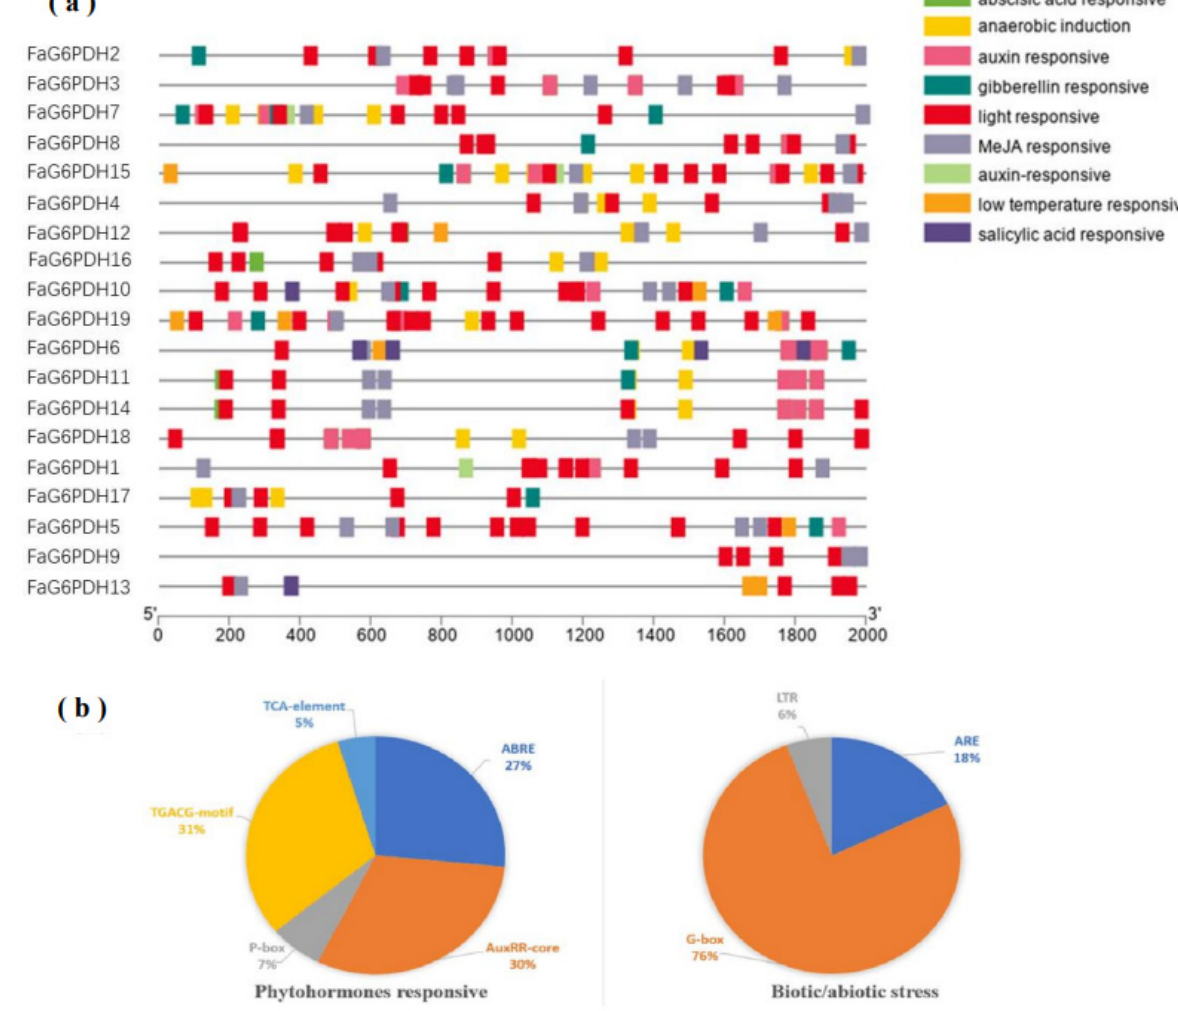
Figure 5. Investigation of cis-regulatory elements of FaG6PDH genes. They were categorized into two groups (phytohormones responsive, and biotic abiotic stress). ( a ) cis-acting elements of each category represented with different colors. ( b ) The size of the pie charts showed the percentage of promoter element in each category.